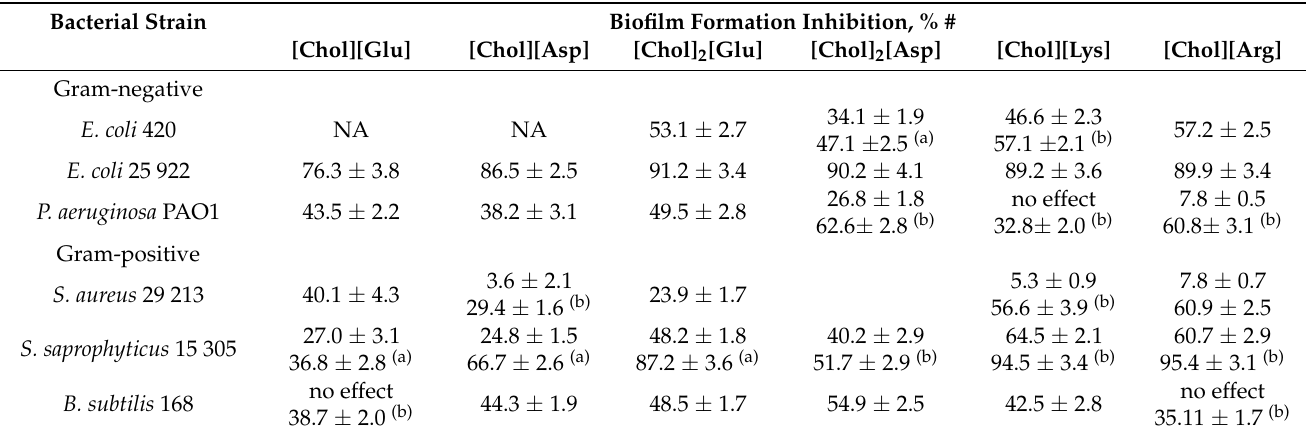
Table 2. Effect of [Chol][AA] on biofilm formation in the presence of 1.37 mmol/L [Chol] n [AA]. Bacterial Strain